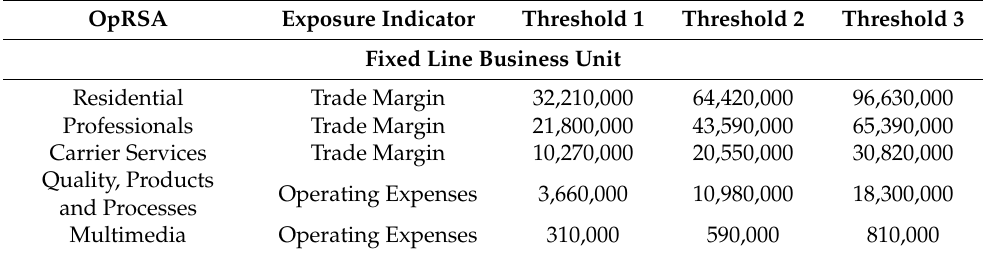
Table 4. Exposure Indicators and Thresholds of BUs (Business Units).